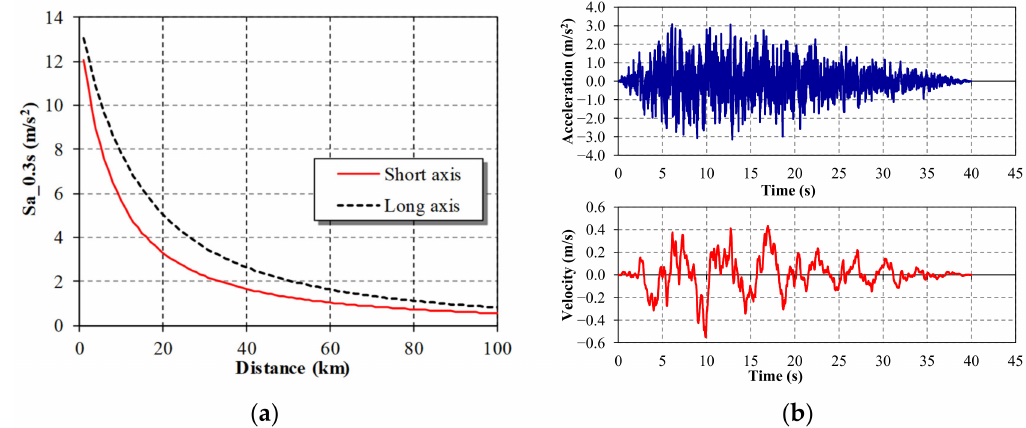
Figure 16. Earthquake data: ( a ) ground motion attenuation functions (M6.5); ( b ) acceleration/velocity time history.